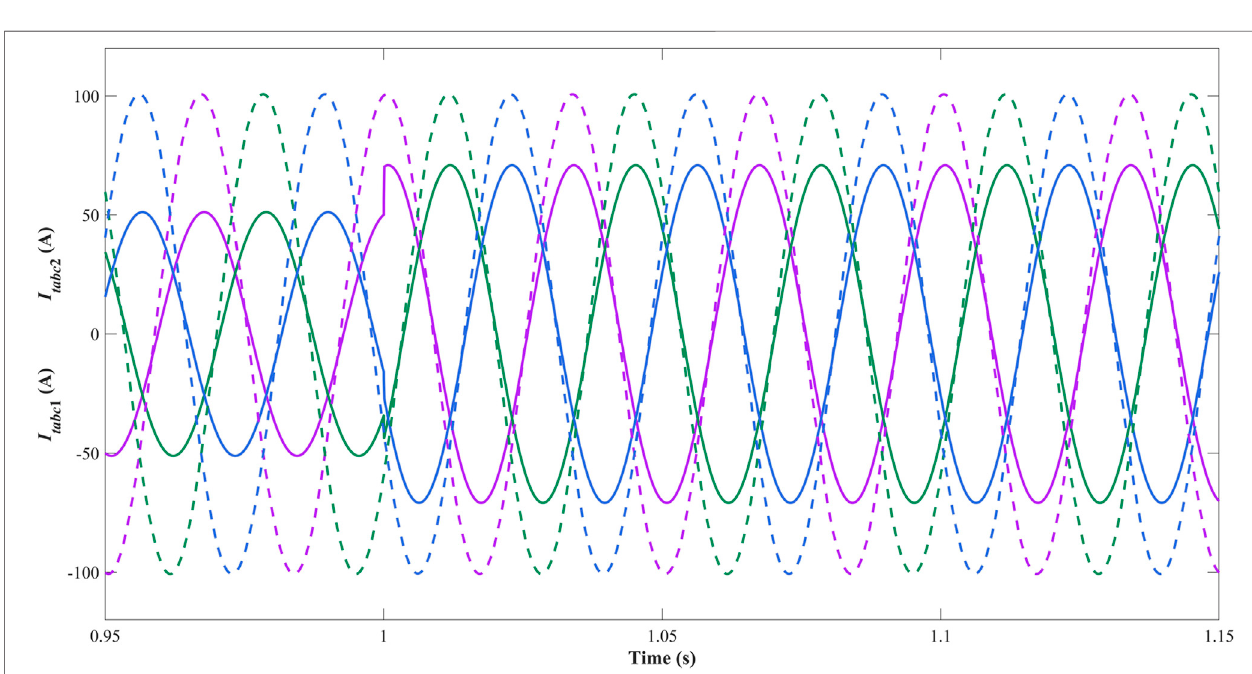
uctuate and remain stable in a short time.